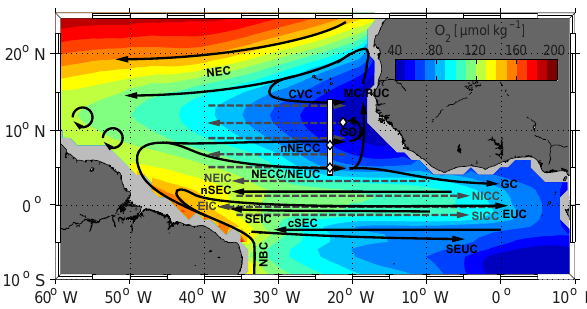
Figure 1. Oxygen concentration in µmolkg − 1 (shaded colors) in the tropical Atlantic at potential density surface 27.1kgm − 3 (close to the deep oxygen minimum) obtained from MIMOC (monthly, isopycnal and mixed-layer ocean climatology) (Schmidtko et al., 2013, 2017). Superimposed arrows denote the mean current field (adapted from Brandt et al., 2015; Pena-Izquierdo et al., 2015). Sur- face and thermocline (about upper 300m) currents (black solid ar- rows) are the North Equatorial Current (NEC), Cape Verde Cur- rent (CVC), Mauritania Current/poleward undercurrent (MC/PUC), Guinea Dome (GD), North Equatorial Countercurrent/North Equa- torial Undercurrent (NECC/NEUC), northern branch of the NECC (nNECC), northern and central branches of the South Equato- rial Current (nSEC, cSEC), Equatorial Undercurrent (EUC), South Equatorial Intermediate Current (SEIC), South Equatorial Under- current (SEUC) and North Brazil Current (NBC). Current branches at intermediate depth (gray dashed arrows) are latitudinally alternat- ing zonal jets (LAZJs) between 5 and 13 ◦ N, North Equatorial In- termediate Current (NEIC), Equatorial Intermediate Current (EIC) as well as the Northern Intermediate Countercurrent (NICC) and Southern Intermediate Countercurrent (SICC). The white bar de- notes the 23 ◦ W section between 4 and 14 ◦ N. White diamonds mark positions of multi-year moored observations used in this